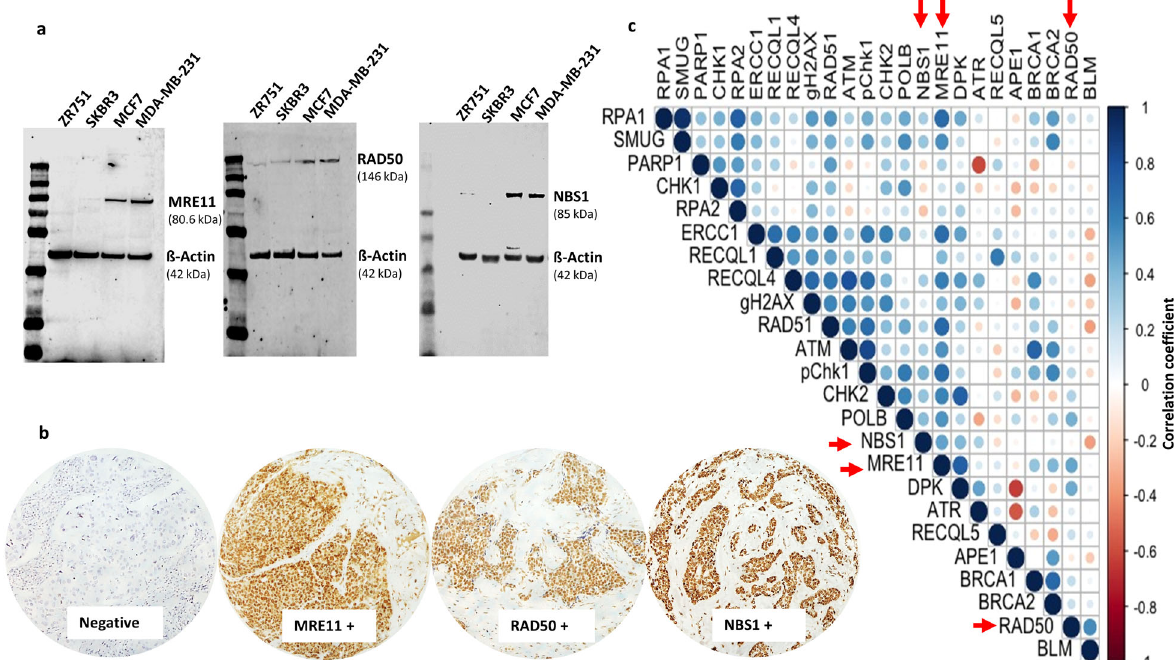
Fig. 1 MRN expression in breast cancers. a Western blot showing MRE11, RAD50 and NBS1 protein expression in a panel of breast cancer cell lines. All blots derive from the same experiment and they were processed in parallel. b Photomicrographs showing immunohistochemical staining of MRE11, RAD50 and NBS1 in breast cancers. c Correlation Matrix showing the correlation between levels of MRE11, NBS1 and RAD50 protein expressions and other DNA repair biomarkers. Blue colour refers to positive ( + ) correlation, while the red colour re fl ects negative ( − ) correlations. The size of the circles and intensity of the colour propionate to the correlation coef fi cient. The image was generated using RStudio software. Red arrow = proteins investigated in the current study i.e. MRE11, RAD50 and